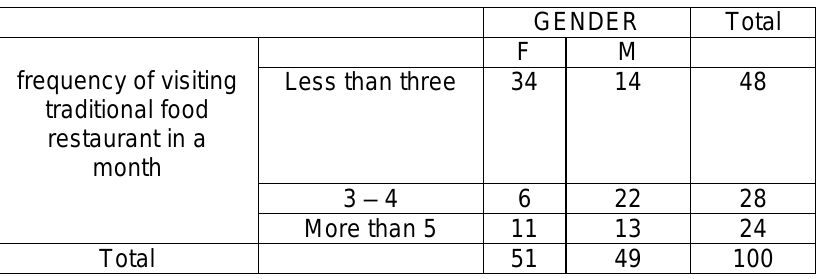
Table 11 Gender and frequency of visiting traditional food